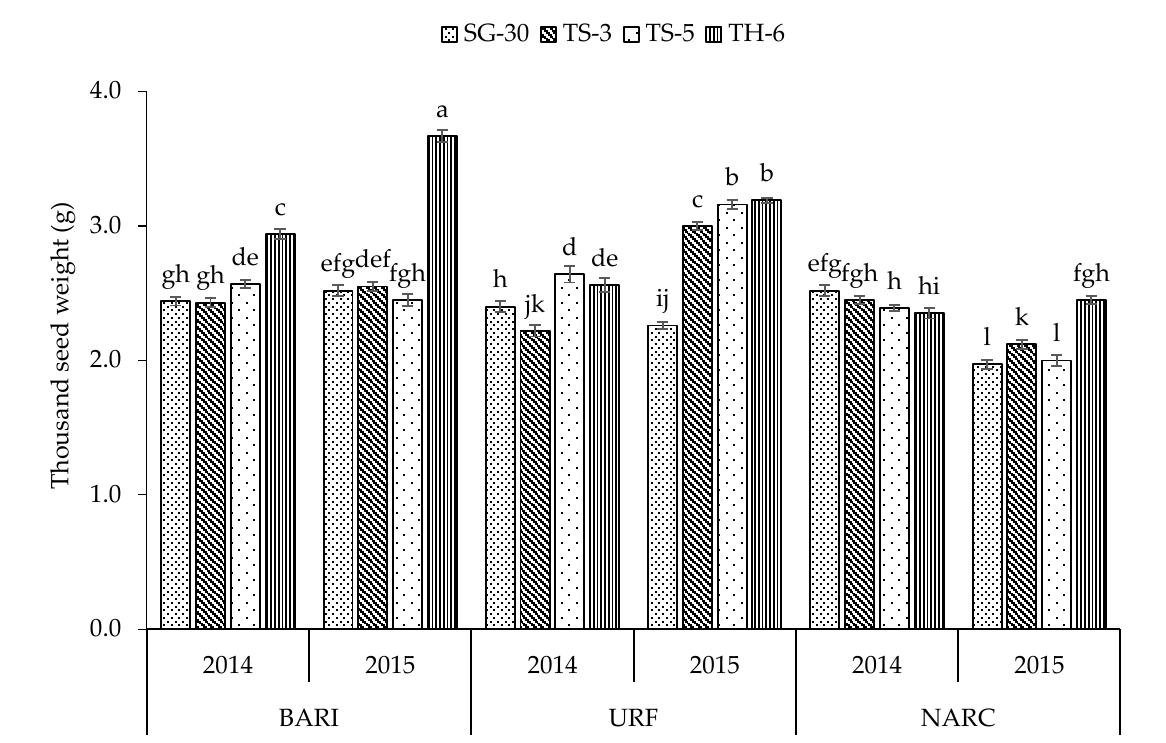
Figure 8. Thousand seed weight (g) of four sesame cultivars at three locations during 2014 and 2015 (pooled over micronutrients). The bars indicates standard error (±SE) of mean (n = 3). All means are significantly different at p ≤ 0.05.